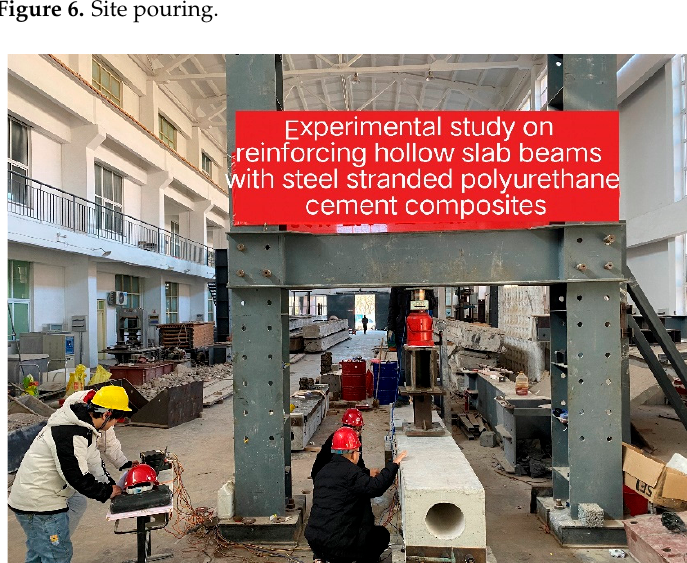
Figure 6. Site pouring.